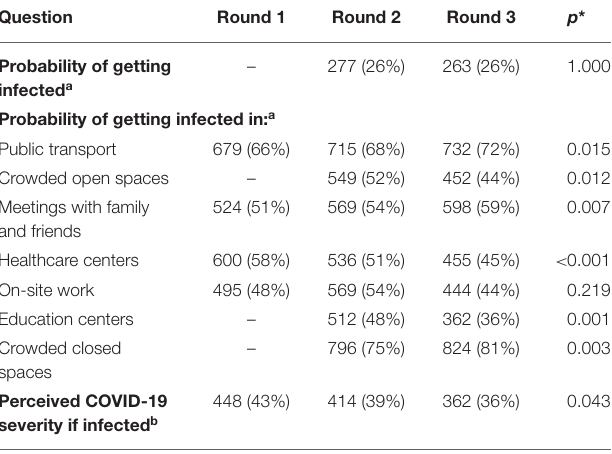
TABLE 5 | Risk perception in each round.